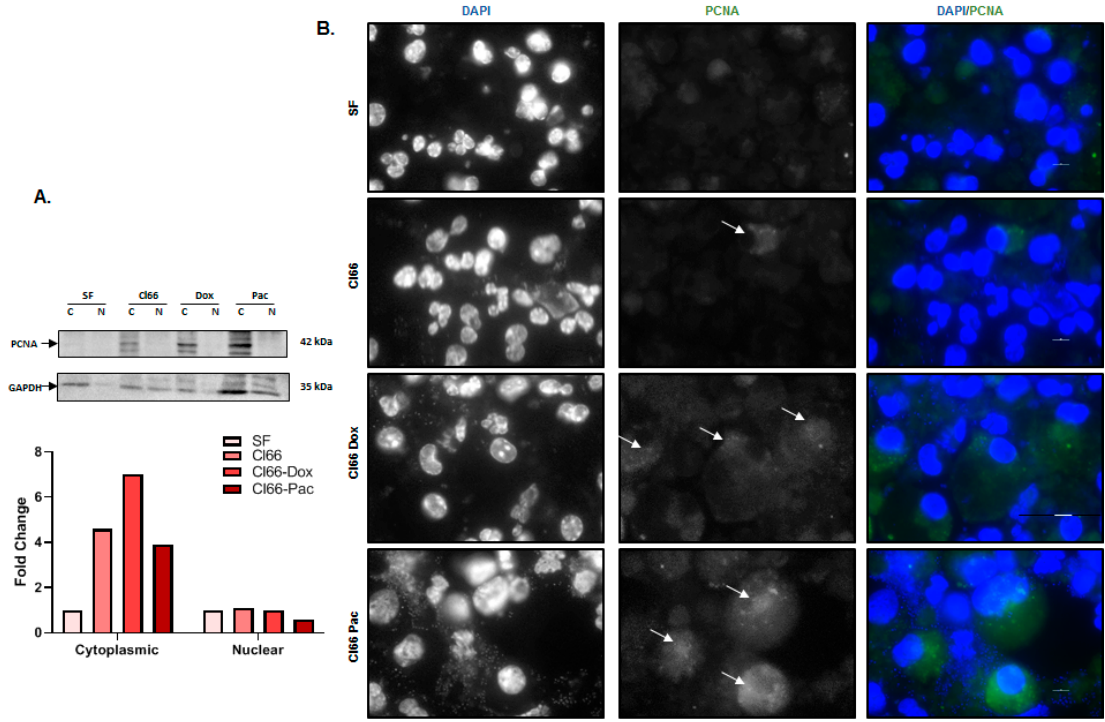
Figure 3. Breast cancer cell-derived factors enhance neutrophil survival by increasing cytoplasmic proliferating cell nuclear antigen (PCNA). ( A ) Western blot and a bar graph show a higher amount of PCNA in the cytoplasm of neutrophils treated with the supernatant of the Cl66, Cl66-Dox, and Cl66-Pac cell lines in comparison with the SF media. Blots were quantified using ImageJ software. Gaphd was used as a loading control and SF as a reference. the whole blot (uncropped blots) is shown in the Figure S1. ( B ) Immunofluorescence images showing a higher amount of PCNA in the cytoplasm of neutrophils treated with the supernatant of the Cl66, Cl66-Dox, and Cl66-Pac cell lines in comparison with SF media. PCNA was stained with the red nucleus as blue (DAPI). The data are representative of three independent experiments with similar results. The scale bar represents 100 μ m.